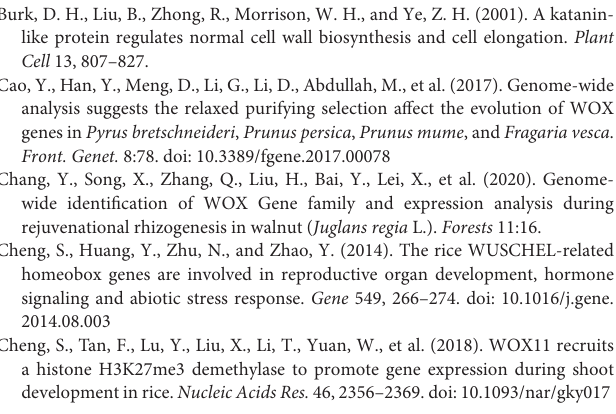
Supplementary Figure 1 | Phylogenetic analysis and protein sequence alignment of PtrWOX13. (A) Phylogenetic tree of WOX proteins from Populus trichocarpa and Arabidopsis thaliana . PtrWOX13 proteins were shown in an orange trapezoid. The tree showed three major phylogenetic subfamilies (subfamilies I–III) that are marked with different colors. (B) AtWOX13A (AT4G35550) protein of A. thaliana aligned with PtrWOX13 proteins from Populus trichocarpa (Potri.005G101800, Potri.002G008800, and Potri.005G252800). The conserved HD and MOG motifs represent by blue arrows and green arrows, respectively; yellow, red, brown, and black boxes represent the YxDpl motif, NVYNWFQNR motif, activation region, and ESExE motif, respectively. Supplementary Figure 2 | Cis -regulatory elements in promoter regions of PtrWOX13 genes and motifs of PtrWOX13 proteins. (A) Motifs of PtrWOX13 proteins. Colors of boxes denote different motifs while lengths of boxes represent relative motif lengths. (B) Venn diagram of common and unique motifs present in promoter regions of PtrWOX13A, PtrWOX13B1 , and PtrWOX13B2 . (C) Cis -regulatory elements in the 2,000 bp promoter sequences upstream of transcription start codons of PtrWOX13A , PtrWOX13B1 , and PtrWOX13B2 genes using the online tool PlantCARE. These elements have different functions, which are represented by different colors. Supplementary Figure 3 | Identification of PtrWOX13A in Populus trichocarpa overexpression transgenic lines. (A) PCR detection of PtrWOX13A transgenic lines. Lane M, DNA marker DL2000; Lane 1, wild type; Lane 2–9. PCR products of PtrWOX13A transgenic lines. (B) qRT-PCR detection of PtrWOX13A transgenic lines. PtrActin was used as a control. Each error bar represents the standard deviation of three biological replicates. Asterisks represent levels of significance (Dunnett’s test; ∗ p < 0.01 < p < 0.05, ∗∗ p < 0.01). (C) 90-day-old wild type (WT) and PtrWOX13A transgenic lines (OE-2, OE-3, and OE-7). Supplementary Figure 4 | Anatomical and histochemical analyses of stems of different developmental stages in Populus trichocarpa transgenic lines. (A–D) Represent phloroglucinol-HCl stained transverse sections of the internode 2 (IN2), 4 (IN4), 6 (IN6), and 8 (IN8), respectively. (E–H) Represent toluidine blue O-stained transverse sections of IN2, IN4, IN6, and IN8 in WT, respectively. (I–L) were phloroglucinol-HCl-stained transverse sections of IN2, IN4, IN6, and IN8 in PtrWOX13A transgenic lines, respectively. (M–P) Represent toluidine blue O-stained transverse sections of IN2, IN4, IN6, and IN8 in PtrWOX13A transgenic lines, respectively. Scale bars = 200 µ m. The toluidine blue and phloroglucinol-HCl were used to stain cell morphology and lignin, respectively. Supplementary Figure 5 | Analysis of PtrWOX13A binding to cis -acting elements by yeast one-hybrid assay. The pHIS2-p53/pGADT7-rec2-p53 and pHIS2-p53/pGADT7-rec2-PtrWOX13A were used as the positive and negative control, respectively. A represents ATTGATTG cis -regulatory element; AM1 and AM2 represent mutated ATTGATTG cis -regulatory elements; T represents TTAATSS cis -regulatory element; TM1 and TM2 represent mutated TTAATSS cis -regulatory elements; 10 − 1 , 10 − 2 , and 10 − 3 represent solution dilution ratio of transformed Y187 yeast